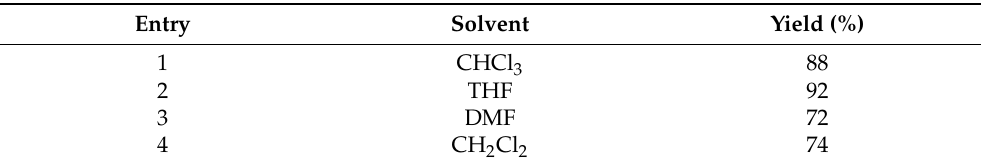
Table 1. Solvent effect on the polymerization carried out under N 2 atmosphere for 24 h in the presence of CuI and Et 3 N. T = 90 ◦ C; [P[5](OTf) 2 ] = [9,10-diethynylanthracene] = 0.30 M; [Pd(PPh 3 ) 2 Cl 2 ] = 0.02 M;